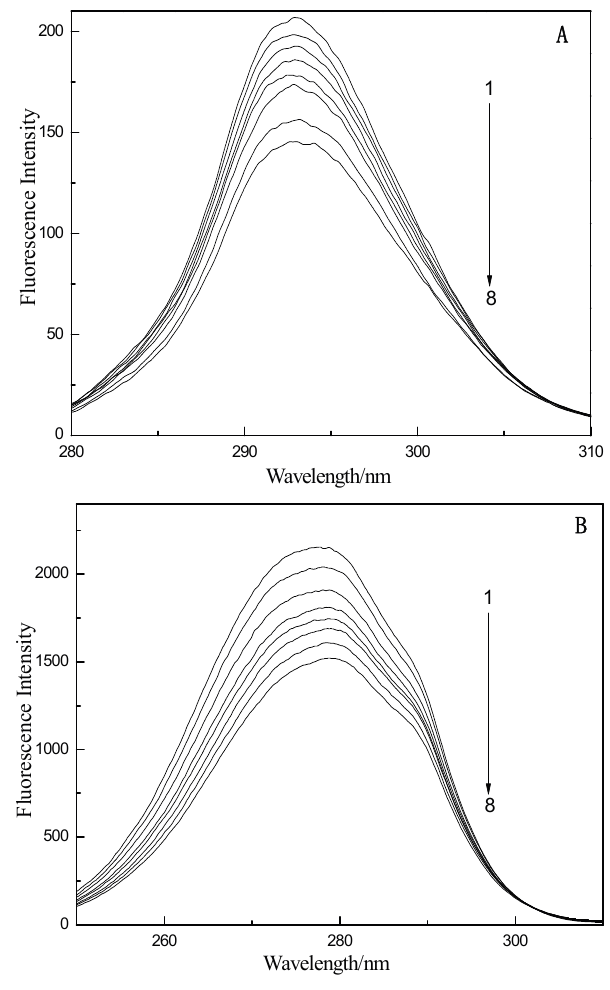
Figure 6. Effect of GA on the synchronous fluorescence spectra of LYS (( A ) Δλ = 15 nm; ( B ) Δλ = 60 nm). c LYS = 1.0 × 10 − 5 mol/L, c GA (1 to 8) = 0.0, 0.4, 0.8, 1.6, 2.8, 3.6, 4.8, 5.6 (×10 − 5